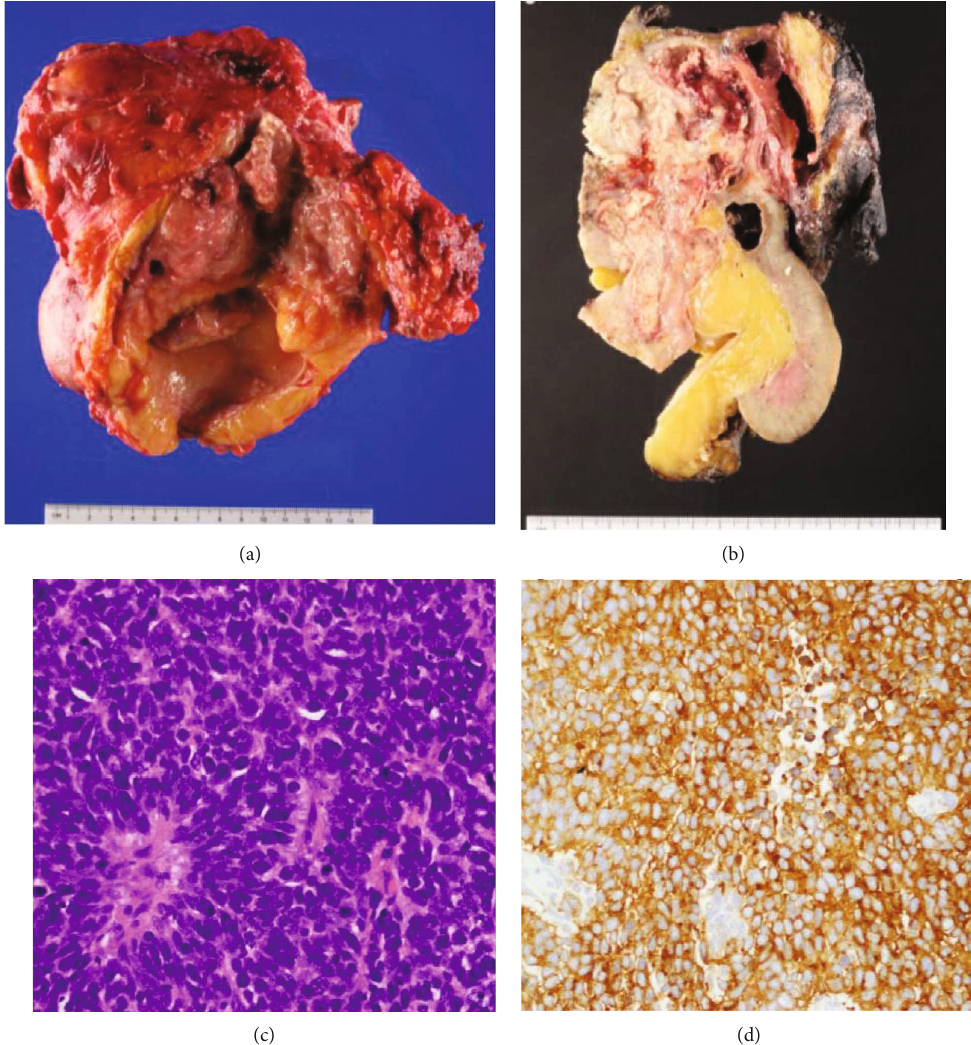
Figure 2: (a) For case 1, nephroureterectomy showed the friable tumor in the dilated ureter. (b) The kidney was bivalved to reveal a 17cm yellow fl eshy mass with hemorrhage and focal necrosis. (c) Hematoxylin and eosin stain showed tumor cells consist of di ff use sheets of small round to oval malignant cells with frequent mitotic activity, exhibiting small-cell features ( × 400). (d) Immunostaining showed tumor cells are strongly positive for synaptophysin ( ×